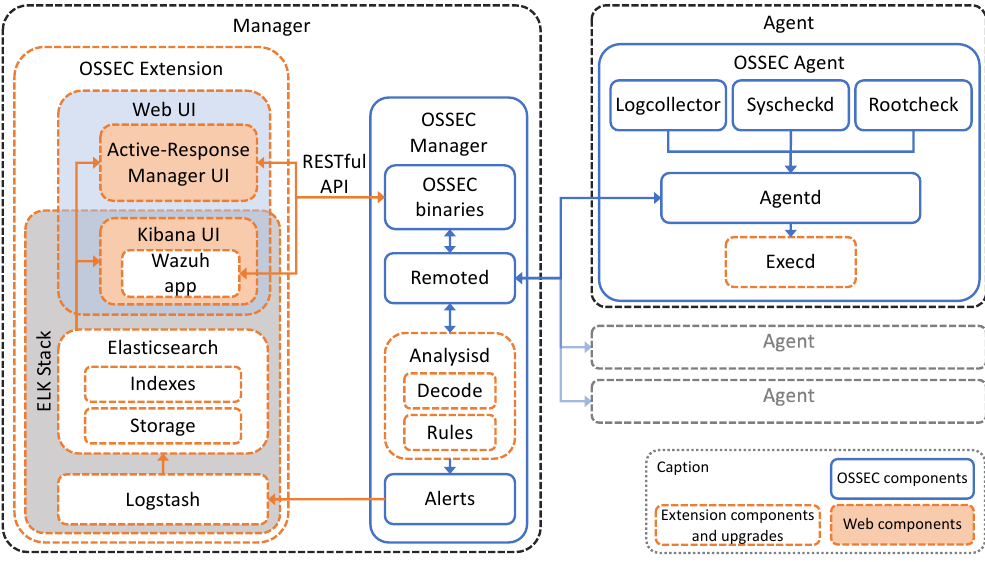
Figure 2. OSSEC components and